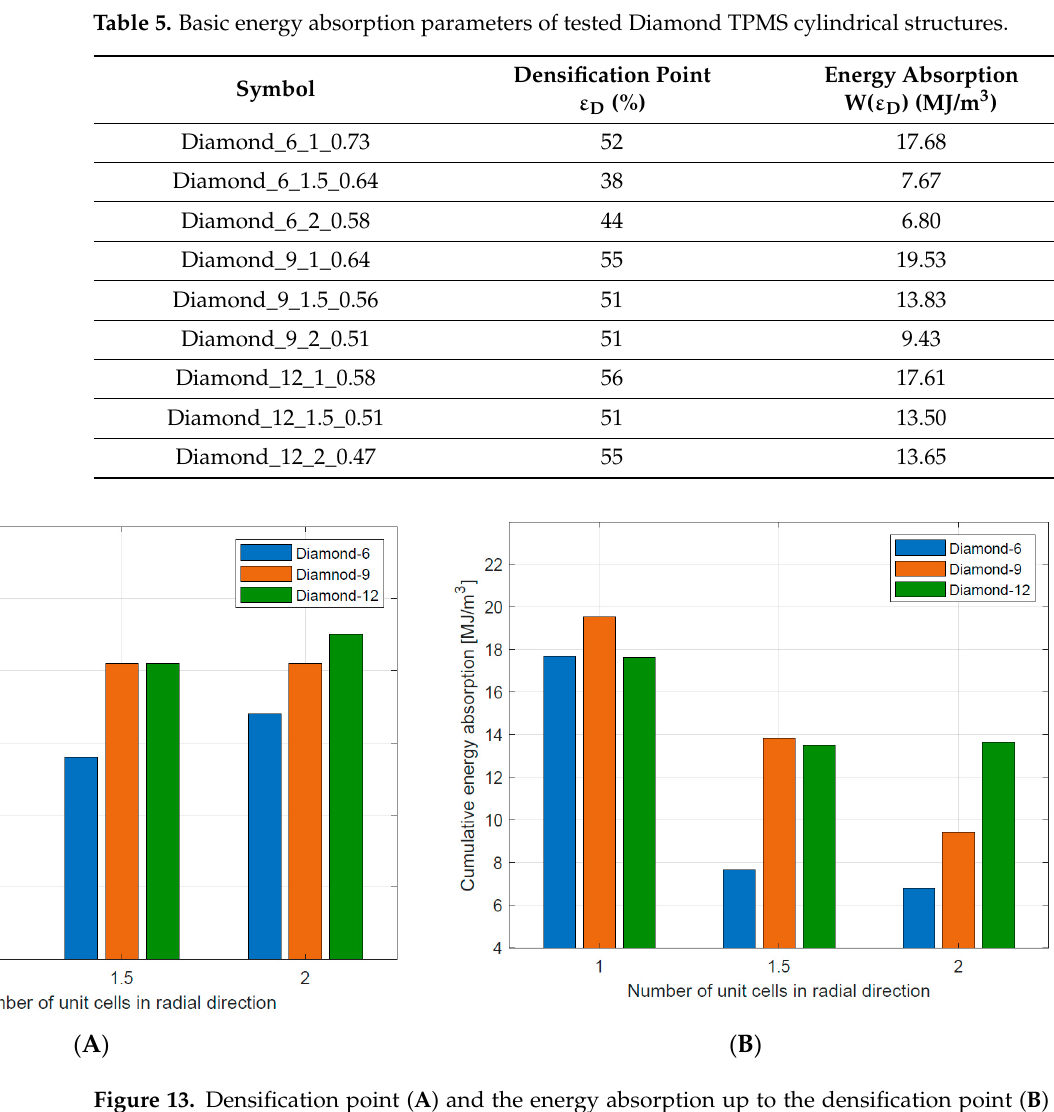
Figure 12. Energy absorption ( A , C , E ) and energy absorption efficiency ( B , D , F ) curve of tested Dia- mond TPMS cylindrical structures.